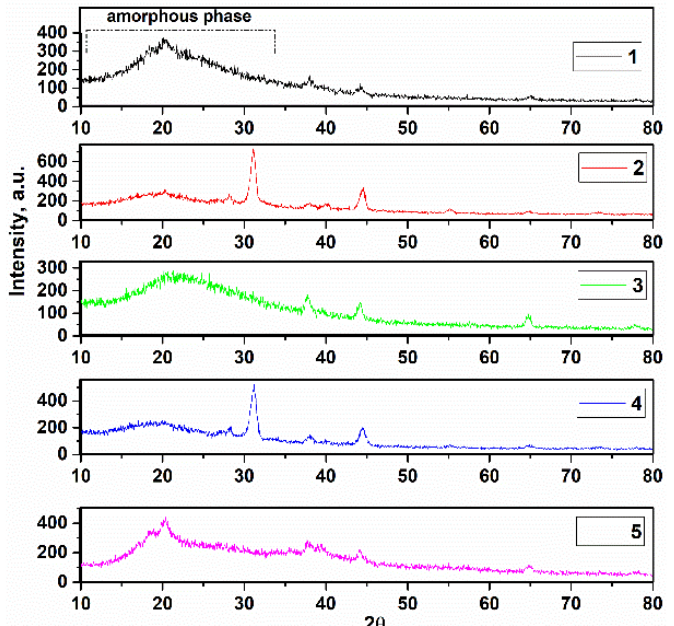
Figure 4. X-ray diffraction of deposited thin films.